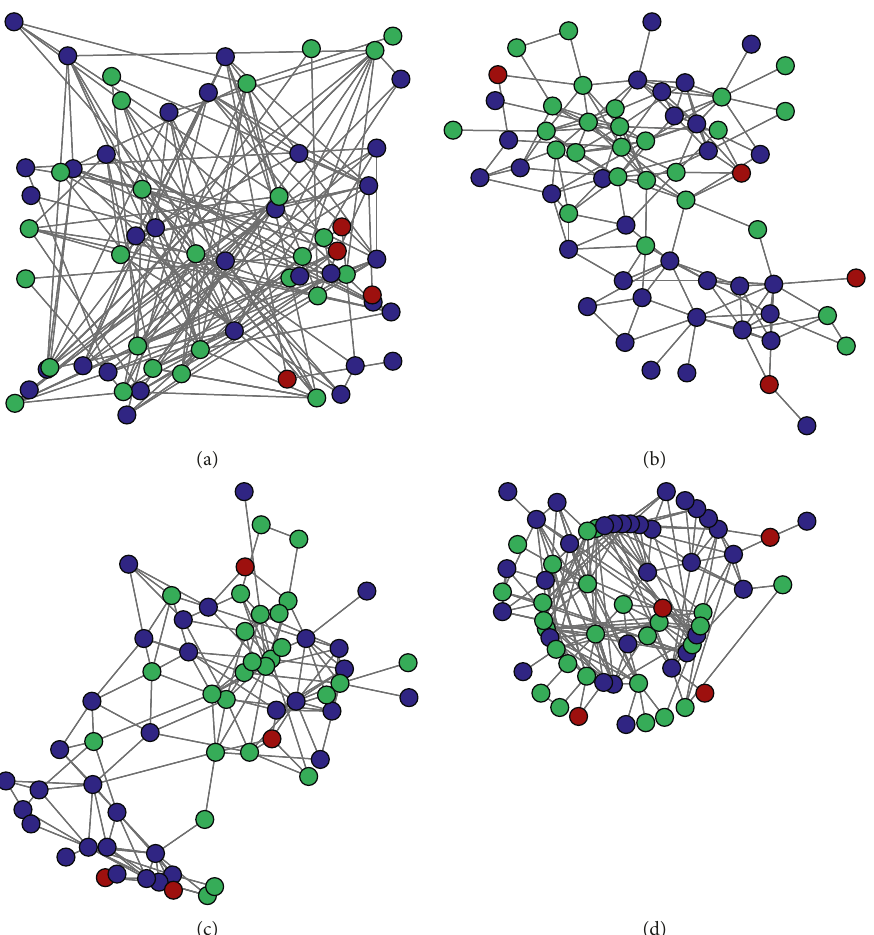
Figure 5: The same dolphin social network [41] represented using different network visualization algorithms: random layout